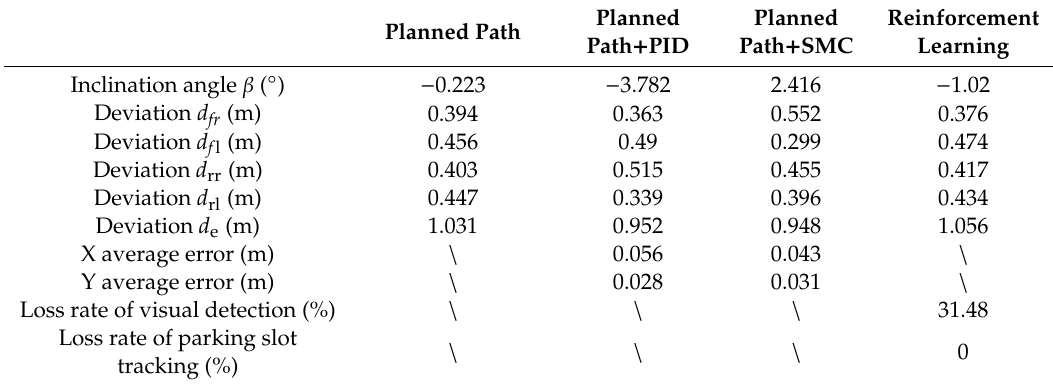
Table 3. Experimental data of 30 ◦ perpendicular